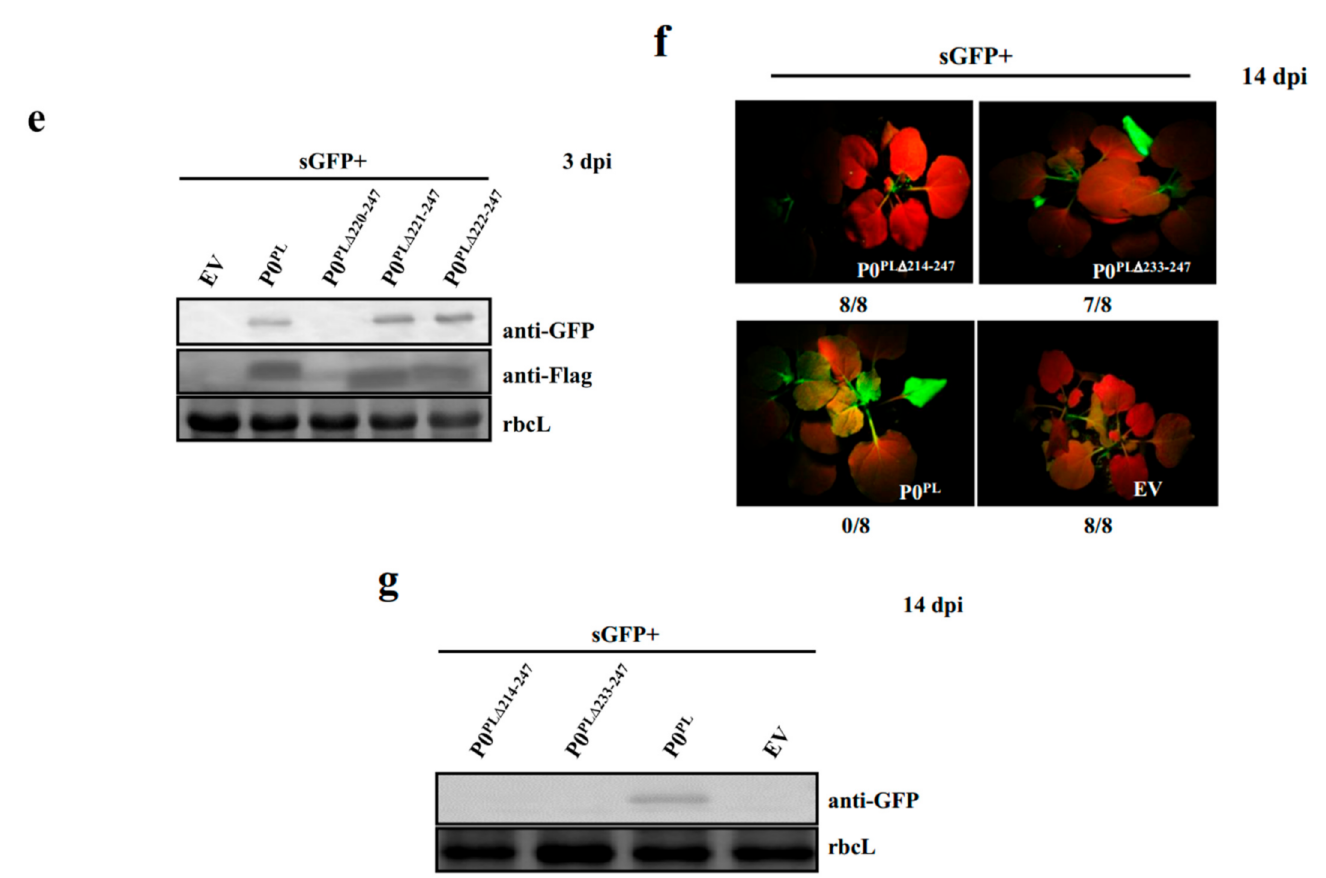
Figure 2. Screening for a suitable truncated region in the C-terminus of P0 PL that abolished local or systemic RNA-silencing suppressor activity. ( a ) Schematic representation of P0 PL and P0 PL truncated mutants used to screen for a suitable region that retained or abolished RNA-silencing suppressor activity. +: Retained; − : Abolished; nd: not examined. ( b ) Analysis of local RNA-silencing suppression. GFP was expressed in co-infiltrated wild-type N. benthamiana leaf patches at 3 dpi under UV illumination. The lowermost right sides of leaves expressed GFP of EV (negative control), the lowermost left sides expressed GFP of wild-type P0 PL (positive control) and the uppermost right and left sides expressed GFP of the P0 PL truncated mutants. ( c – e ) Western blotting analyses of GFP and 3Flag-tagged P0 PL or P0 PL truncated mutants in co-infiltrated leaf patches of N. benthamiana using a GFP polyclonal antibody (anti-GFP) and a Flag monoclonal antibody (anti-Flag), respectively. Stained rubisco is shown to indicate equal lane loading. ( f ) Analysis of systemic RNA-silencing suppression. GFP was expressed in the systemically infected leaves of respective co-infiltrated N. benthamiana line 16c plants at 14 dpi under UV illumination. Designations are specified at the lowermost right sides of pictures, whereas bottom numbers denote silencing ratios. ( g ) Western blotting analyses of GFP from the P0 PL or P0 PL truncated mutants in the systemically infected leaves of respective N. benthamiana line 16c plants using a GFP polyclonal antibody (anti-GFP). Stained rubisco is shown to indicate equal lane